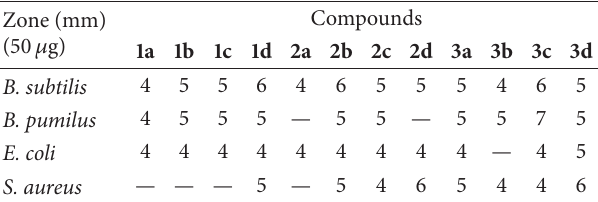
Table 2: Antimicrobial activity of synthesized compounds.